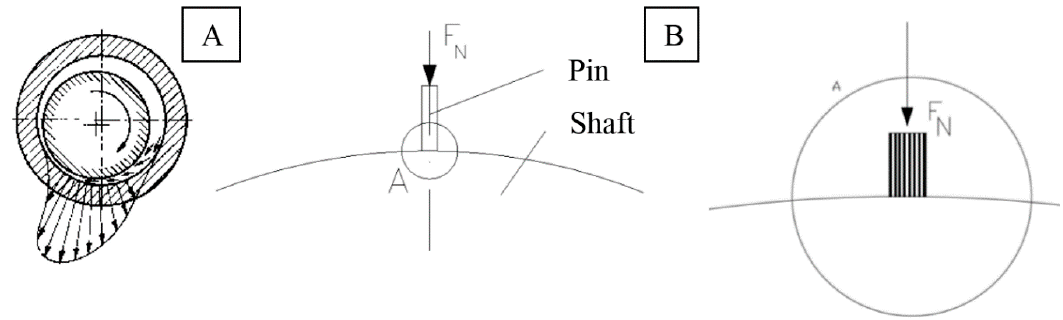
Figure 5. ( A ) Force distribution in a slide bearing, ( B ) contact: composite sample—shaft end, Figure 5. (A ) Force distribution in a slide bearing, ( B ) contact: composite sample — shaft end, detail — detail—distributed contact of composite sample and shaft end. distributed contact of composite sample and shaft end.